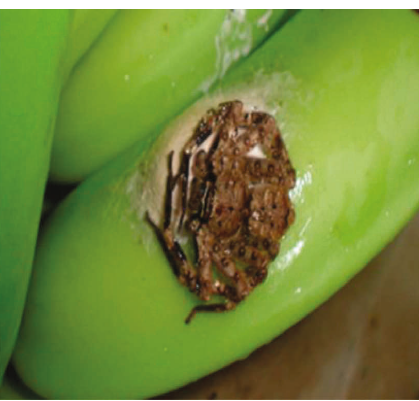
Figure 2: Female Holconia insignis spider guards over her egg